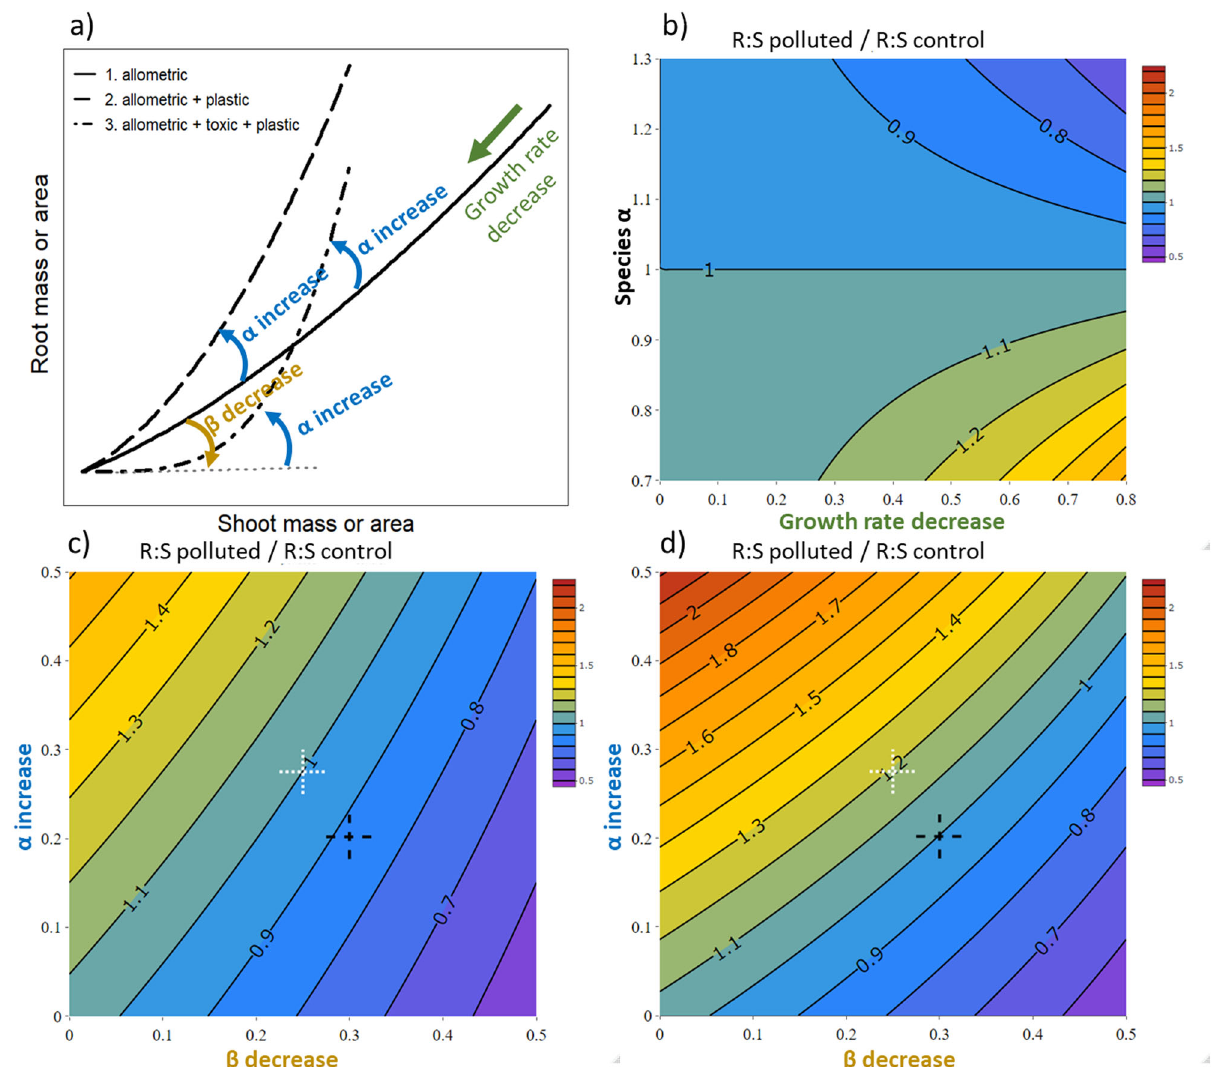
Fig. 4 Synthesis of plant response to soil pollution stress and modelling of corresponding changes in root: shoot (R:S) ratio. a Different possible plant development trajectories (in natural scale). In all cases, the phytotoxic effect decreases growth rate leading to plants with smaller roots and shoots (green arrow in the top right corner). The baseline development shown has an α coef fi cient >1. Case 1 (solid line): no plasticity of biomass in response to